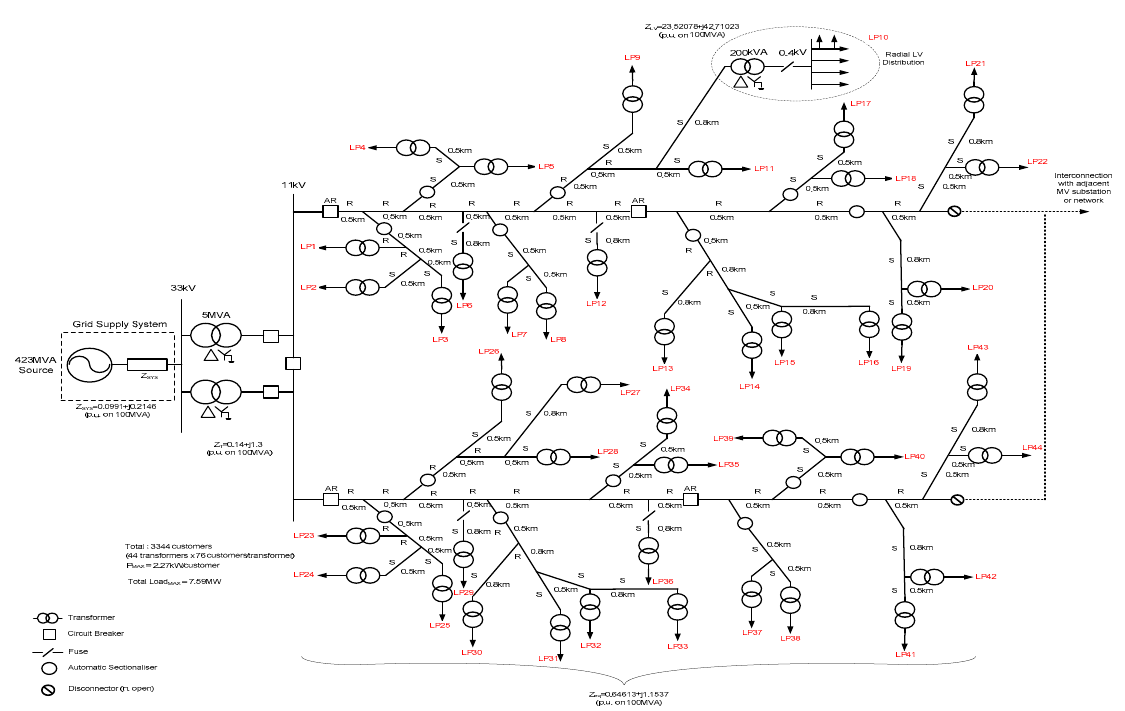
Figure 1. Typical distribution network configuration supplying suburban residential load [22–27]. Table 1. Parameters of Typical 11, 0.4, and 0.23 kV Feeders [22,28–30].